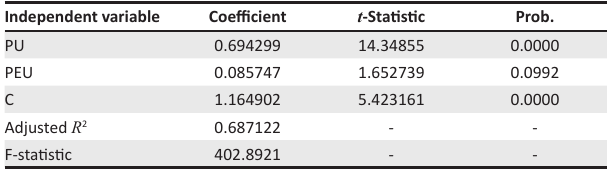
TABLE 6: Model 1 – Regression analysis with Bartlett-Kernel, Newey-West adjustments for heteroskedasticity.